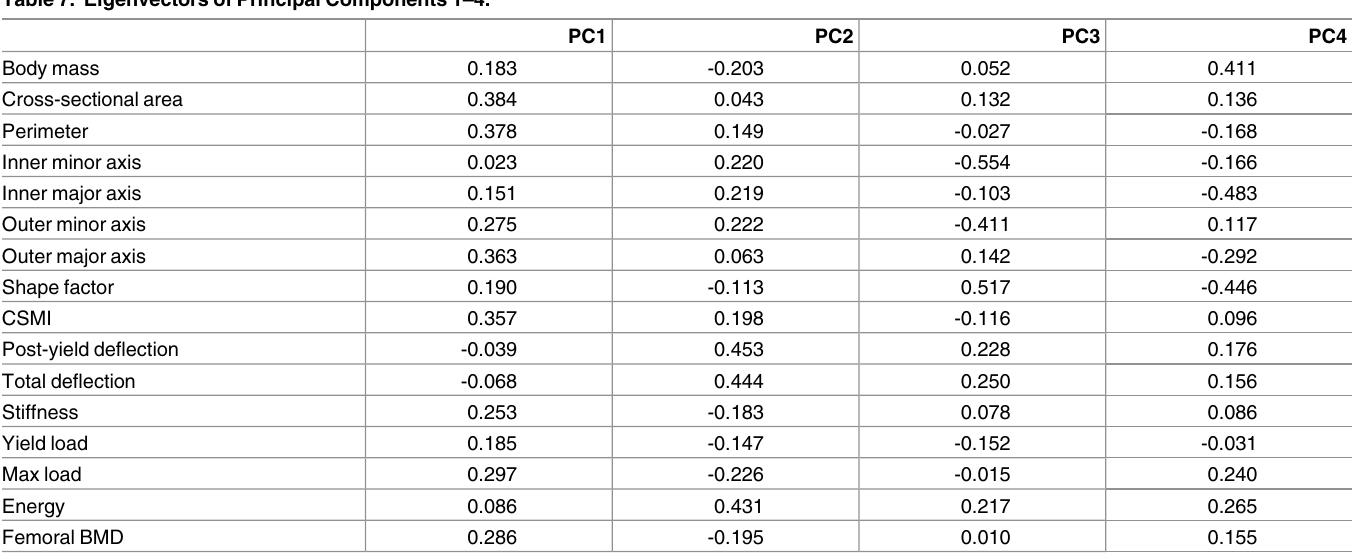
Table 7. Eigenvectors of Principal Components 1–4.